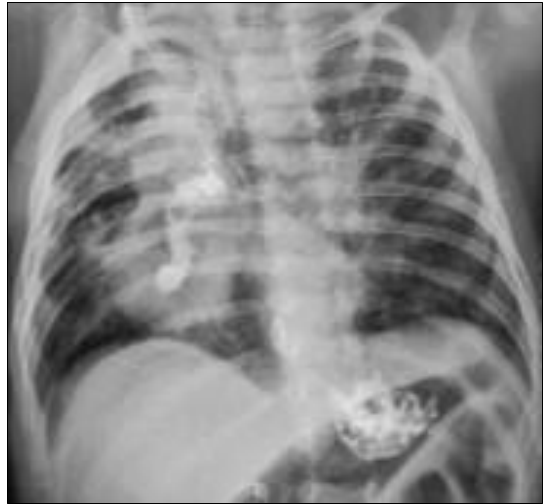
Figure 1: Contrast study with oral Iohexol. The leak of contrast from the esophagus into a cavity in relation to